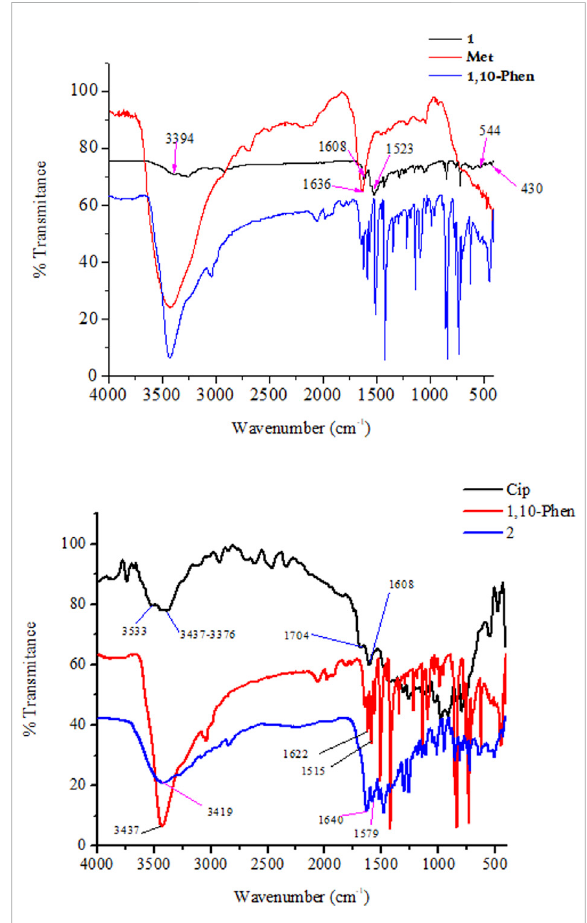
FIGURE 1 FTIR Spectra of the synthesized metal complexes 1 (top) and 2